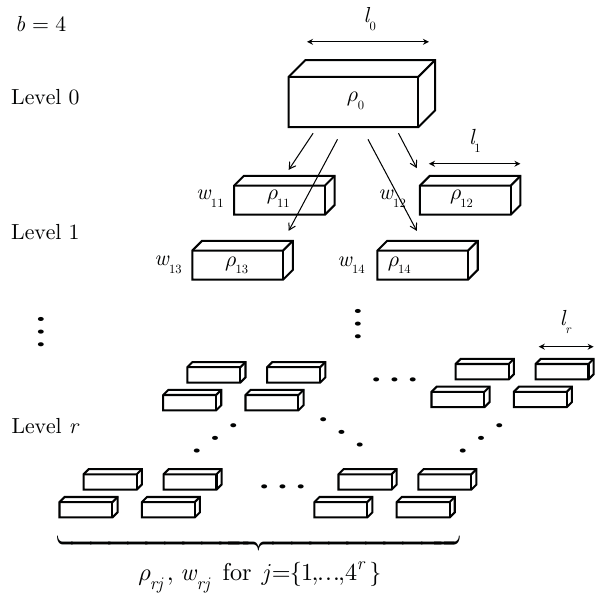
Figure 1. Cascade